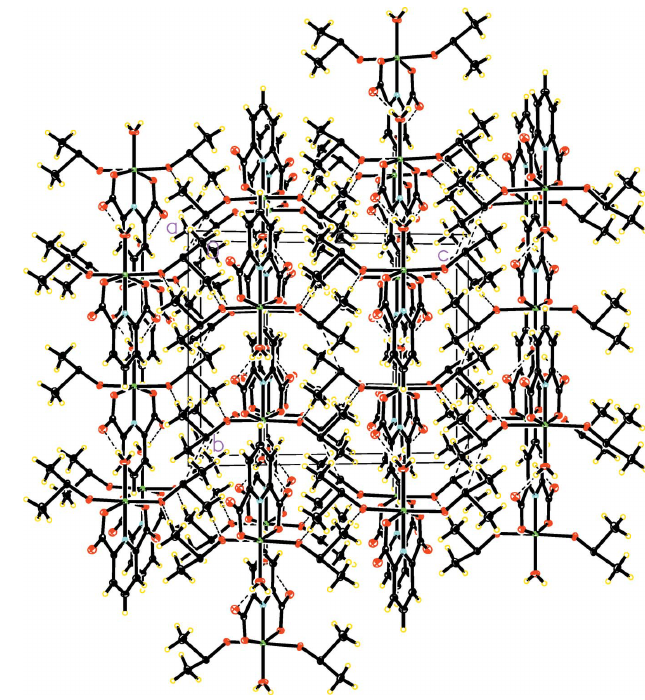
Figure 2 The crystal packing of the title compound, showing hydrogen bonds as (cid:2) z dashed lines. 2